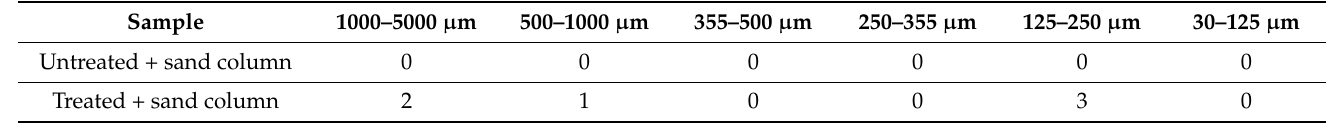
Table 1. Concentration of microplastic particles, before and after the